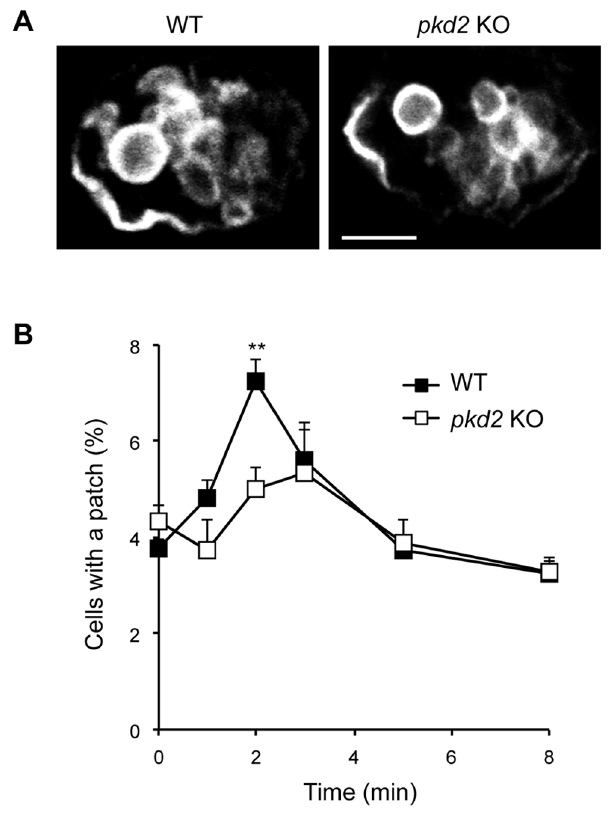
Figure 4. PKD2 is essential for calcium-induced lysosome exocytosis. A) Confocal image of typical exocytic p80 patches in WT and pkd2 KO cells. Scale bar: 5 m m. B) Percentage of cells exhibiting an exocytic patch after transfer to a medium containing 1 mM CaCl 2 . WT cells showed a rapid and transient increase in fusion events, peaking after 2 minutes, while no induction of lysosome exocytosis was seen for pkd2 KO cells. ** p , 0.01, compared to WT values at each time point; n=5.